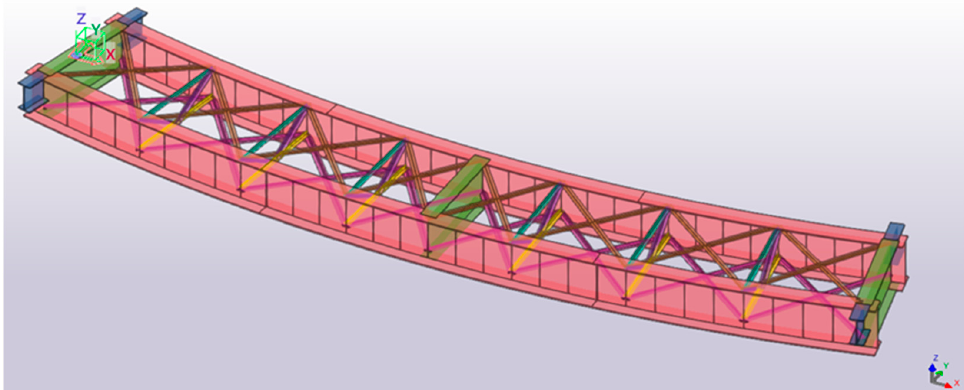
Figure 6. Elements transfer from Rhinoceros 3D to Tekla Structures. Girders, cross-beams, and bracing systems development.